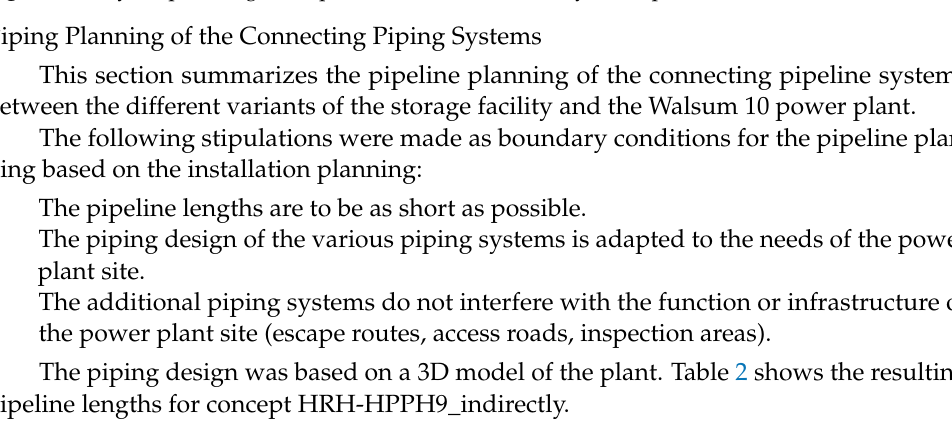
Figure 26. Layout planning concept HRH-HPPH9_indirectly—Site plan.